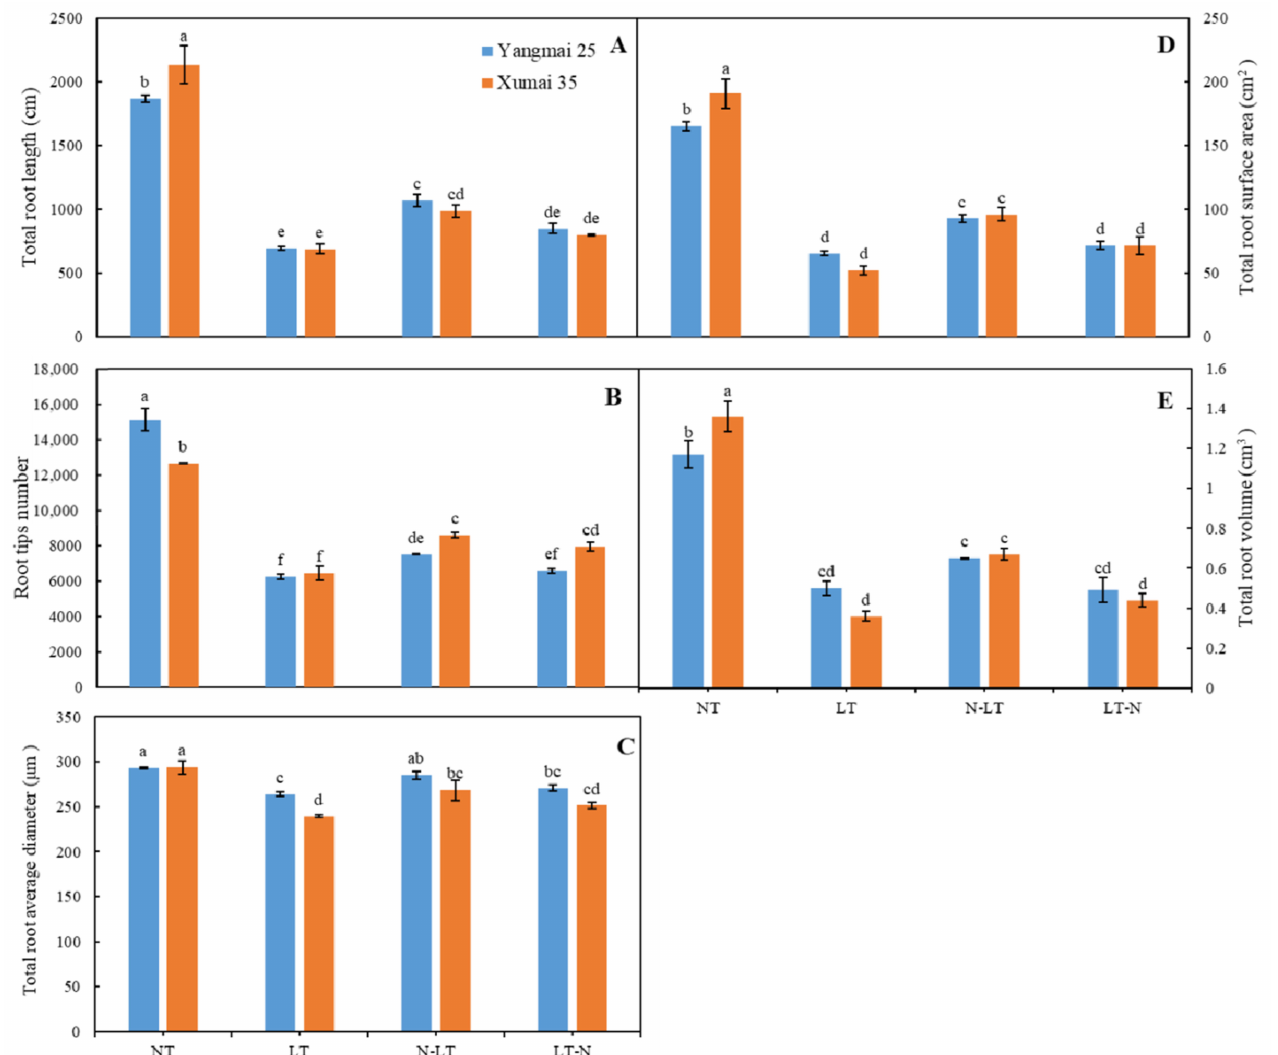
Figure 3. Total root length ( A ), number of root tips ( B ), total root average diameter ( C ), root surface area ( D ), and total root volume ( E ) of Yangmai 25 and Xumai 35 among the different treatments. Vertical bars denote standard error of mean, and different letters were significantly different at p ≤ 0.05 probability level. NT, Normal temperature control; LT, Low-temperature treatment at 4-leaf stage; N-LT, Application of 15 N urea prior to low-temperature stress at 4-leaf stage; LT-N, Application of 15 N urea post low-temperature stress at 4-leaf